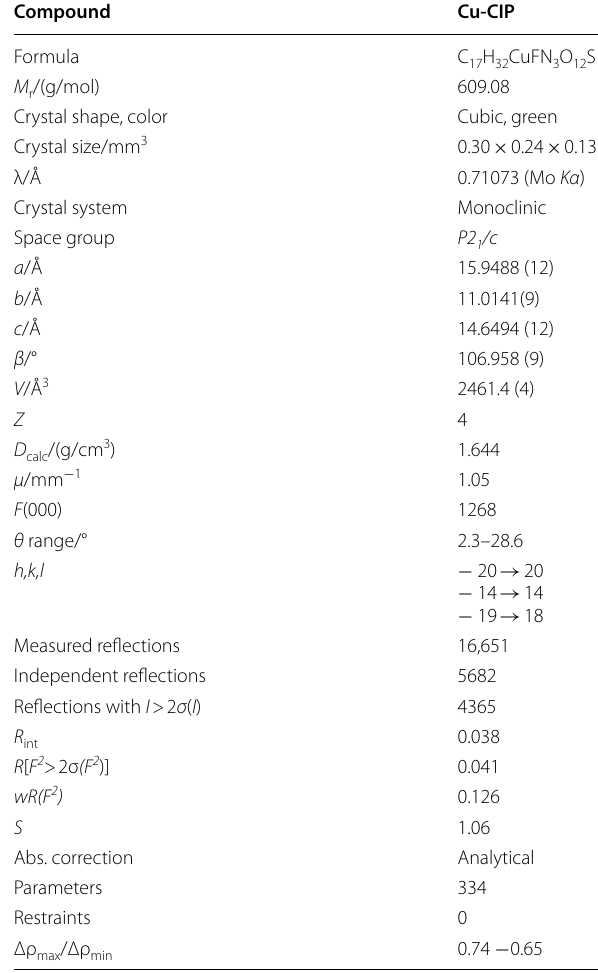
Table 1 Crystallographic data and refinement